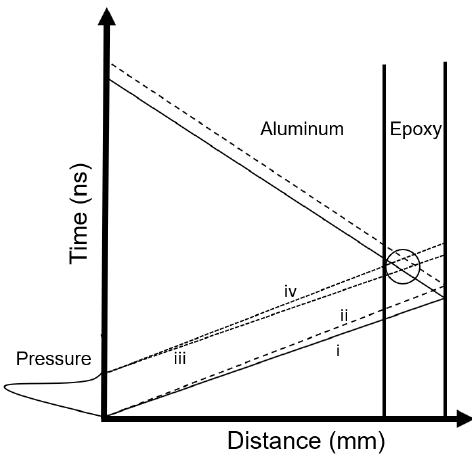
Figure 2. Schematic illustration of the shock wave propagation into the aluminum/epoxy system. (i) Elastic precursor, (ii) plastic shock, (iii) elastic decompression shock and (iv) plastic decompres- sion shock.